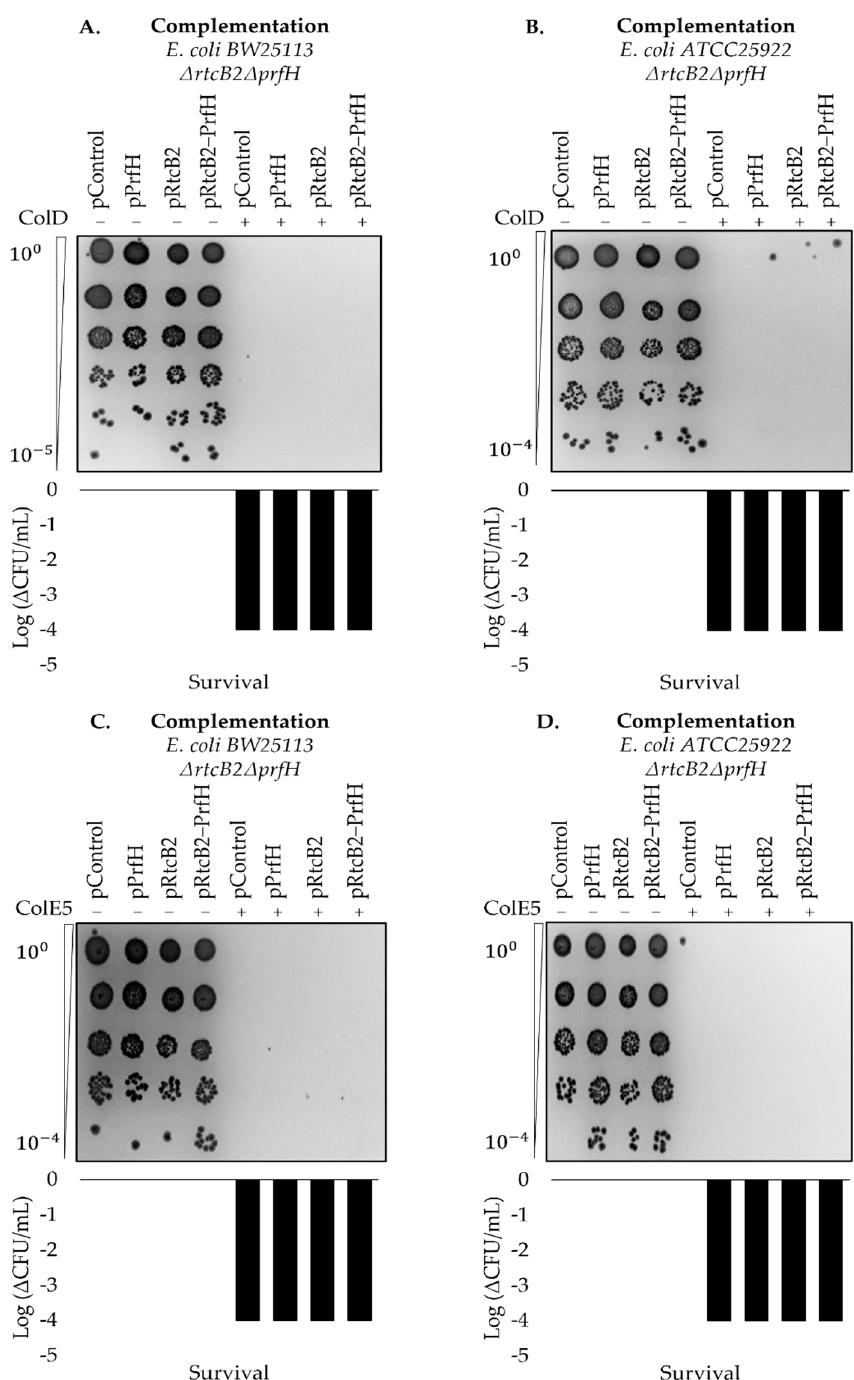
Figure 4. Survival upon colicin E5 and D treatment. The results demonstrate a decline of cell titer after serial dilutions. This is a demonstration of survival assay(s) in rtcB2 - prfH double knockout cells, transformed by complementation plasmids in both E. coli BW25113 and E. coli ATCC25922 strains treated with recombinant colicin D (for ( A , B )) and E5 (for ( C , D )) at log-phase, respectively. The results were consistent and reproducible on repeat at least twice.